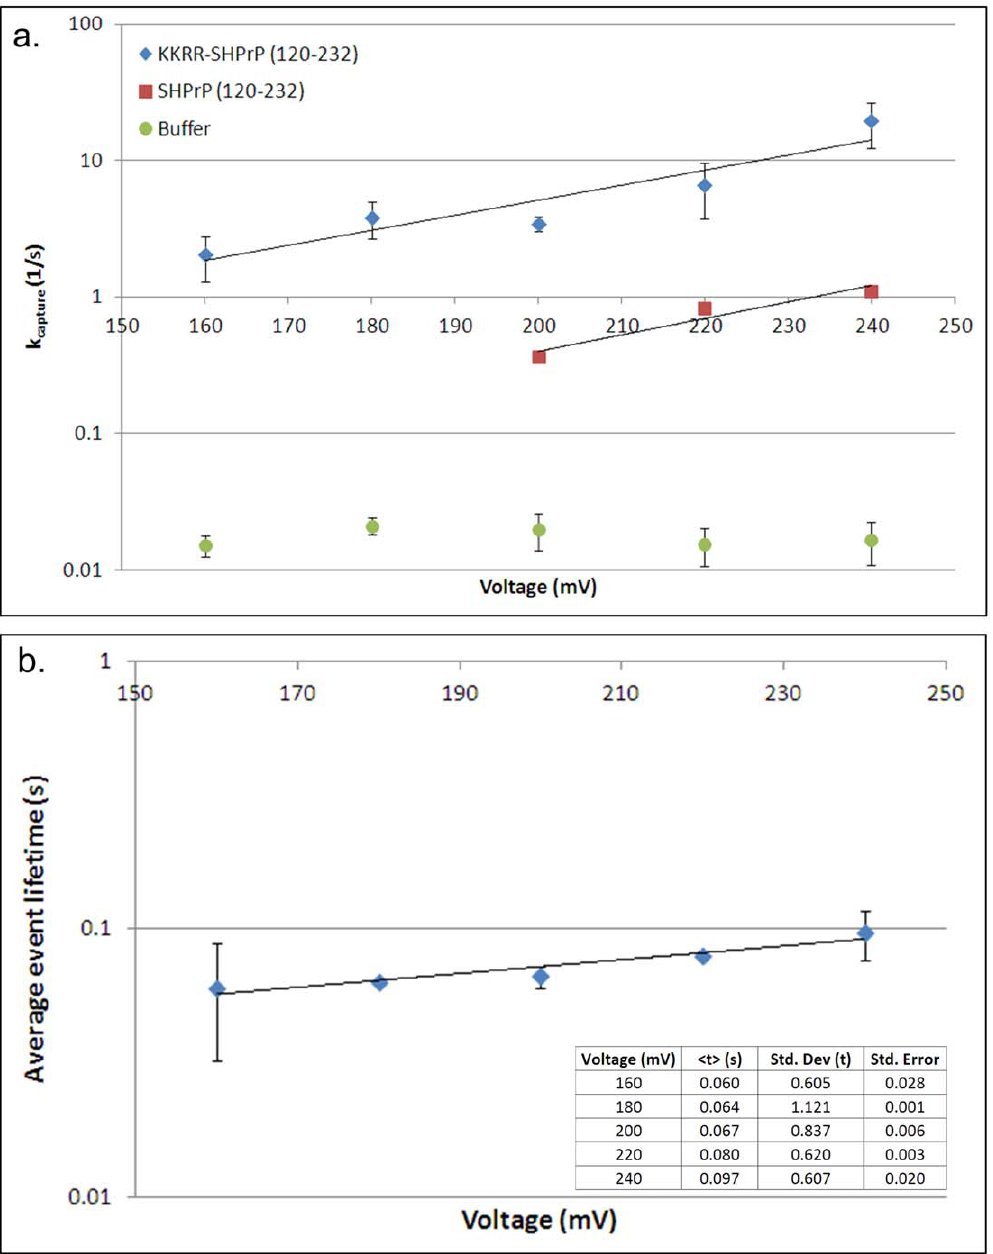
Figure 2. Nanopore capture rate and KKRR-ShPrP(120–232) average event lifetime as a function of voltage (3 M KCl cis , 0.3 M KCl trans ). ( a ) Shown is the capture rate as a function of voltage for KKRR-ShPrP(120–232) (blue), ShPrP(120–232) (red) and the buffer-only control (green). In the case of the buffer-only control the capture rate represents the rate of pore gating as a function of voltage. Both KKRR-ShPrP(120–232) and ShPrP(120–232) exhibit capture kinetics that are exponentially dependent on voltage consistent with the applied voltage acting on the positively charged residues at the N-terminus (five in the case of KKRR-ShPrP(120–232) and one in the case of ShPrP(120–232)) to decrease the energy barrier height for entry into the pore, thereby exponentially increasing the capture rate. In addition, the capture rate for KKRR-ShPrP(120–232) is between one and one-and-a-half orders of magnitude higher than ShPrP(120–232) indicating that the large majority of captures of KKRR-ShPrP(120–232) involve threading of the N-terminus through the pore. Error bars represent the standard error on the mean, and were determined via bootstrapping in the case of ShPrP(120–232) and the buffer-only control, whereas in the case of KKRR-ShPrP(120–232) error bars were determined based on two separate datasets. ( b ) The average event lifetime for KKRR-ShPrP(120–232) increases exponentially with voltage consistent with PrP C escape from the pore (as opposed to translocation) over an electrostatic energy barrier (governed by the applied voltage). The standard deviation of the event lifetime distribution indicates the presence of both short and very long time events (i.e. . 1 s). Error bars represent standard error on the mean and were determined based on two separate datasets.